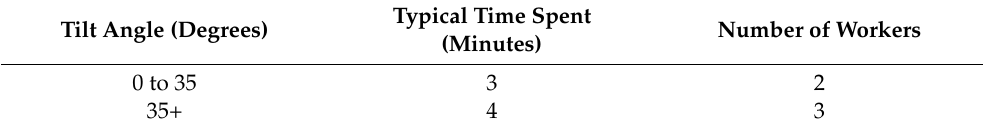
Table 4. Number of workers and time required for changing the tilt angle in different cases.